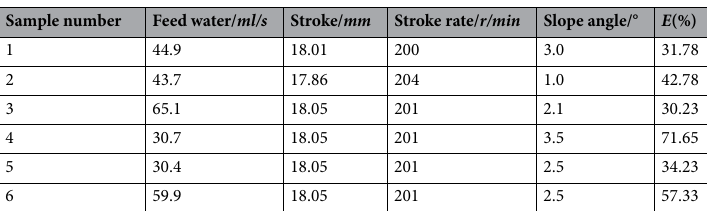
Table 4. Control parameters to be optimized and current beneficiation efficiency E.